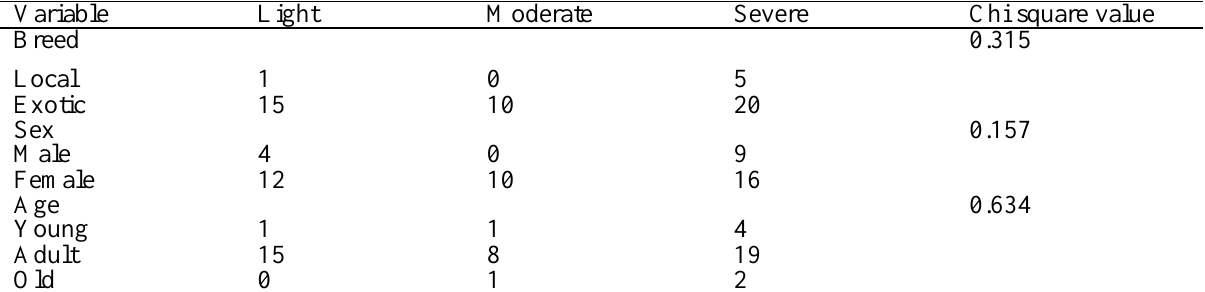
Table 3: EPG category in relation to predisposing factors.